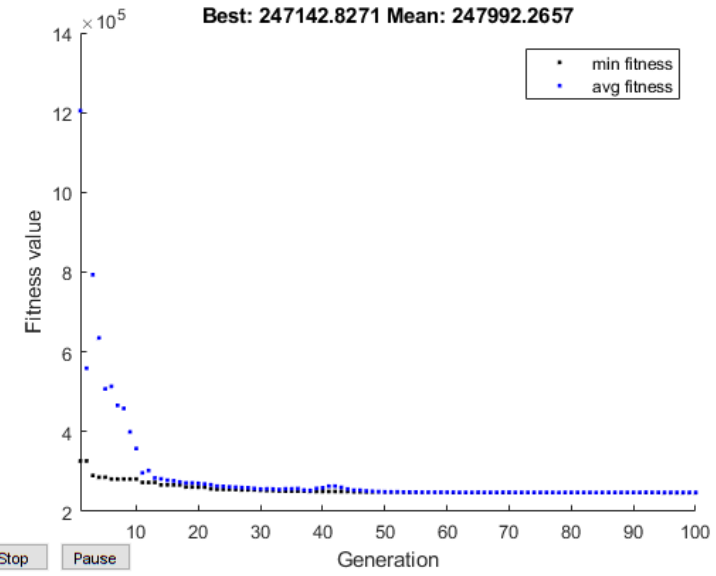
Figure 22. Best and average fitness evolution in control strategy #5 when minimizing V ovf . Table 15. Simulation results when the volume of overflow is minimized (strategy #5). Tank